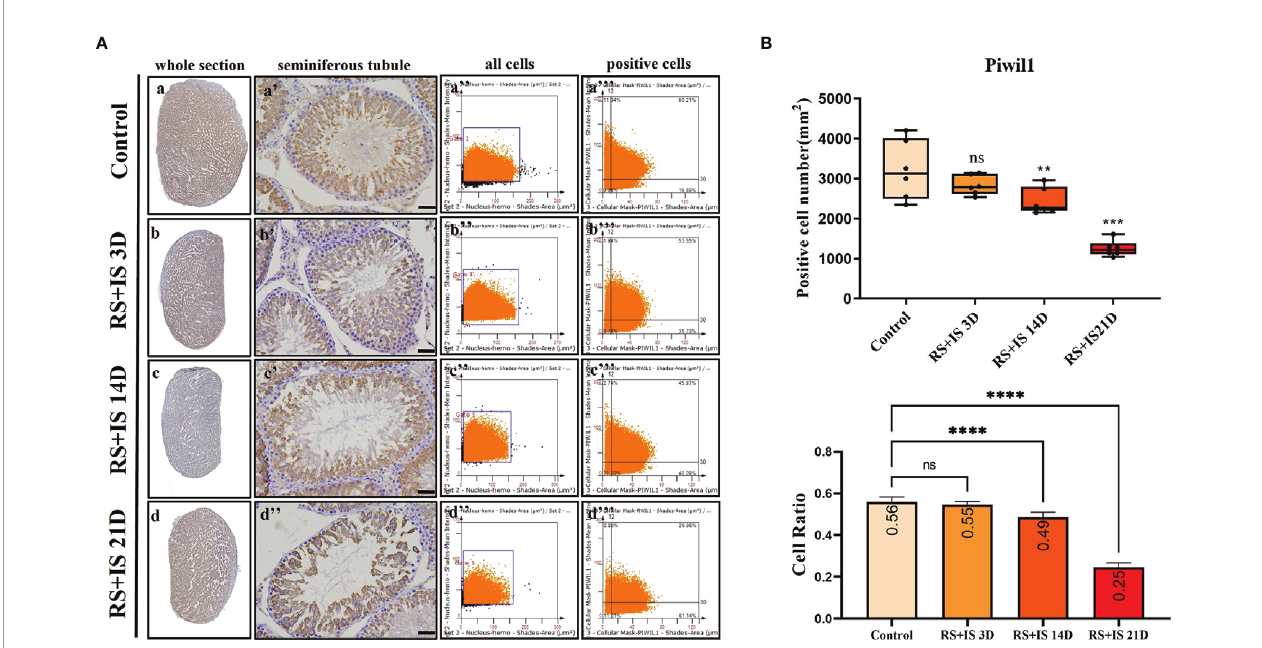
FIGURE 7 | (A) IHC expression of Piwil1. (a – d) show the section of testis. (a ’– d ’ ) show the seminiferous tubule (Bars = 50 m m). (a ’’– d ’’ ) positive points represent all cells. (a ’’’– d ’’’ ) all the positive points in the right upper quadrant represent the positive cells. (B) Box plot shows Piwil1 (upper)-positive cell counting number; each point represents one section. Bar plot (lower) shows Piwil1-positive cell ratio (positive cell counting/all cell counting), n = 6. Values with different superscripts indicate signi fi cant differences between control and treatment groups on one-way ANOVA (** P < 0.01, *** P < 0.001, **** P < 0.0001). ns, non-signi fi cant.